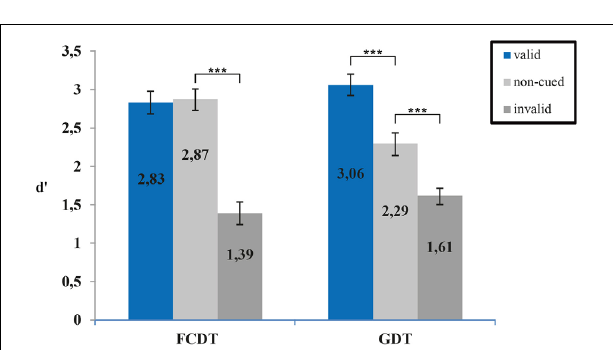
FIGURE 2 | Mean sensitivity indices ( d (cid:48) ) for invalid, uncued and valid trials in the two tasks testing for spectral (FCDT) and temporal (GDT) resolution. Valid cuing significantly improved gap detection but not detection of a frequency change ( ∗∗∗ p < 0.001 post hoc t